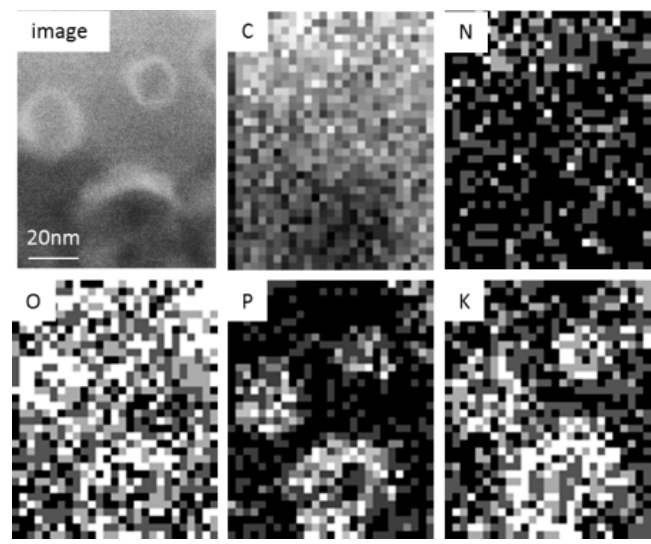
Figure 7. STEM dark field image and corresponding EDX elemental maps of a substrate surface. Top left is the STEM image of 3 “pits” (from lower left part of Figure 4b) and followed by the corresponding EDX maps for different elements.